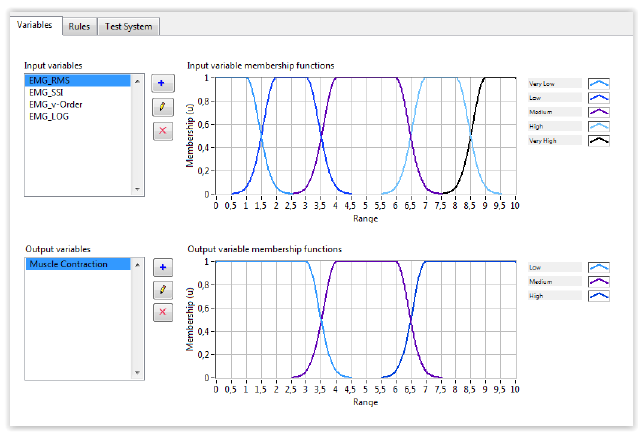
Figure 8. Muscle contraction estimation